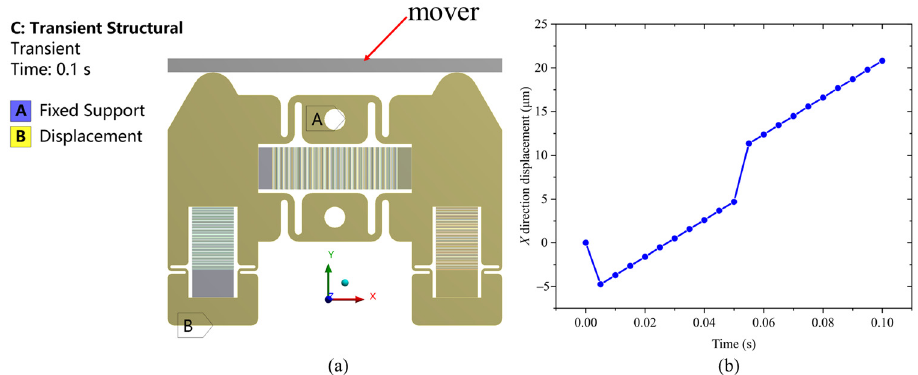
Figure 7. ( a ) Boundary conditions of the actuator in transient dynamic simulation; ( b ) displacement curve of the mover along the X direction in one period, where the driving and clamping voltage amplitudes are 150 V and 120 V, respectively.